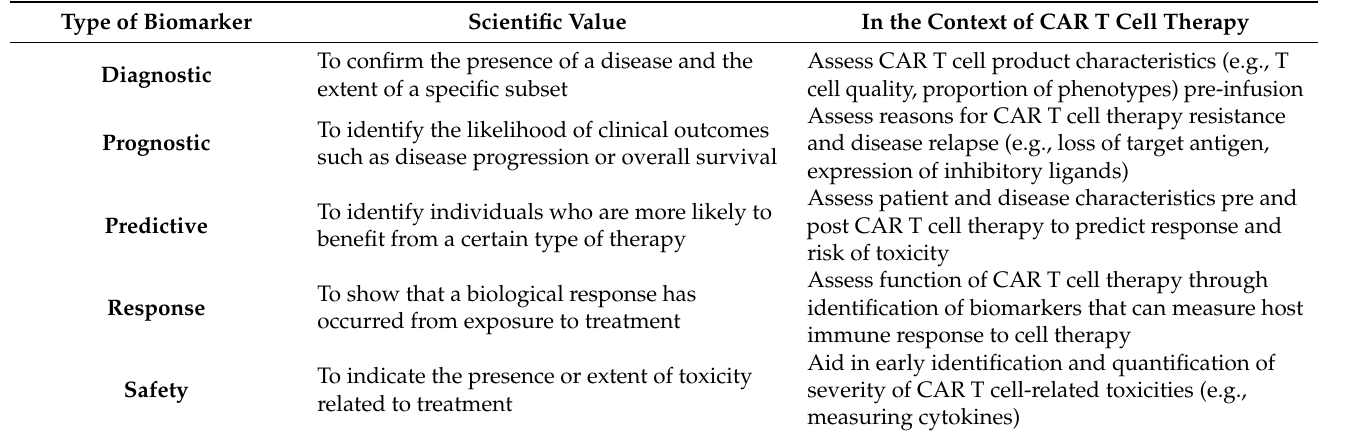
Table 1. The different types of biomarkers as well as each ones scientific value